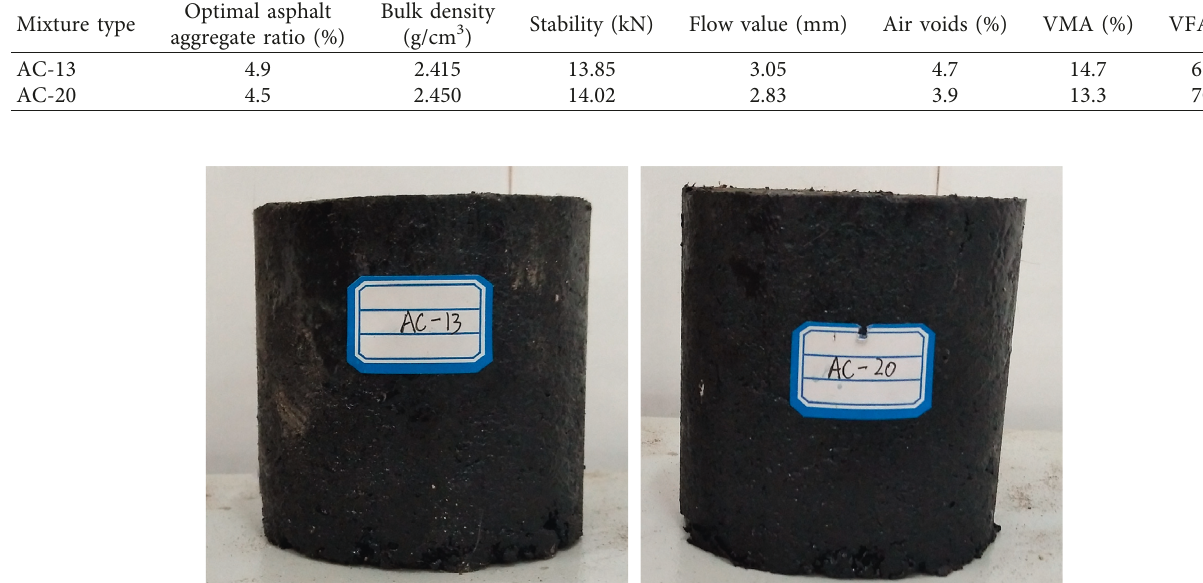
Figure 6: Asphalt mixture specimens ((a) AC-13, (b) AC-20).